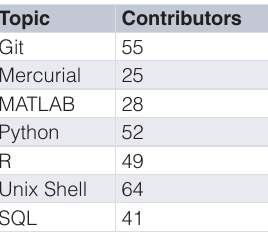
Table 2. Authors per Lesson (October